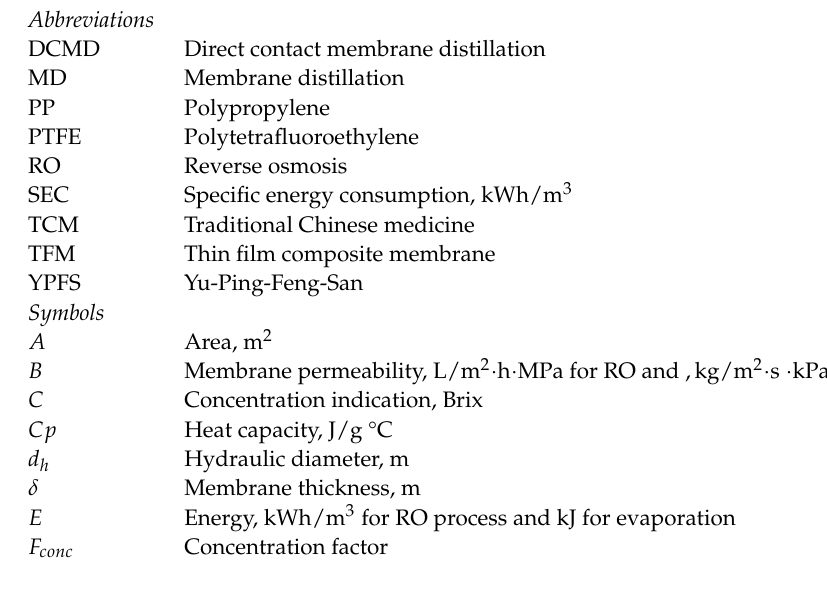
of RO MATLAB modelling algorithm, Figure S6: Flowchart of MD MATLAB modelling algorithm, Table S1: Table of Yu-Ping-Feng-San (YPFS) solution properties correlations, Table S2: Summary of MD membrane cell information, Table S3: Summary of vapor pressure correlation experiments